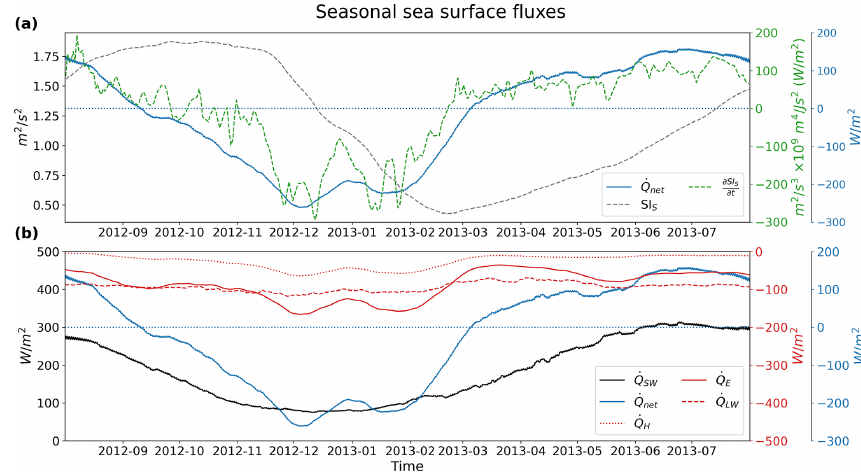
Figure 9. The smoothed (with Eq. 6) seasonal surface heat fluxes over the point 42 ◦ N, 5 ◦ E for the seasonal simulation. Pane (a) contains the seasonal stratification index, SI S , and its derivative, ∂ SI S , comparing it to the seasonal net heat flux, Q net (the subscript S is dropped for ∂t convenience). Panel (b) shows the net heat flux separated into its components: Q E , Q H , Q SW , and Q LW for latent heat flux, sensible heat flux, shortwave downward flux, and longwave downward flux, respectively (neglecting contributions from precipitation and snowfall). The different line colors correspond to the similarly colored axes.